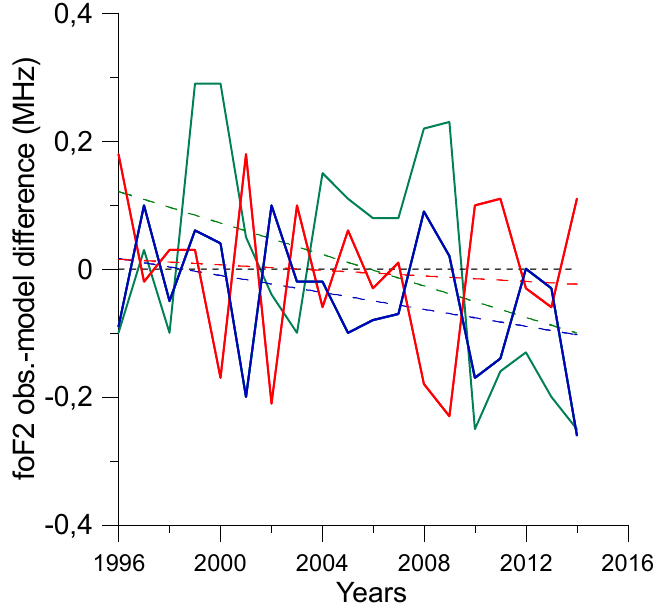
Figure 3. Differences between observed and empirical model yearly values of foF2 for Pruhonice, 1996–2014. Green curve—solar activity proxy F10.7; blue curve—solar proxy F30; red curve—solar proxy Mg II; longer-dash colored lines—respective linear trends; short-dash black horizontal line—zero difference level. Negative difference means smaller value observed than in model. From [17].